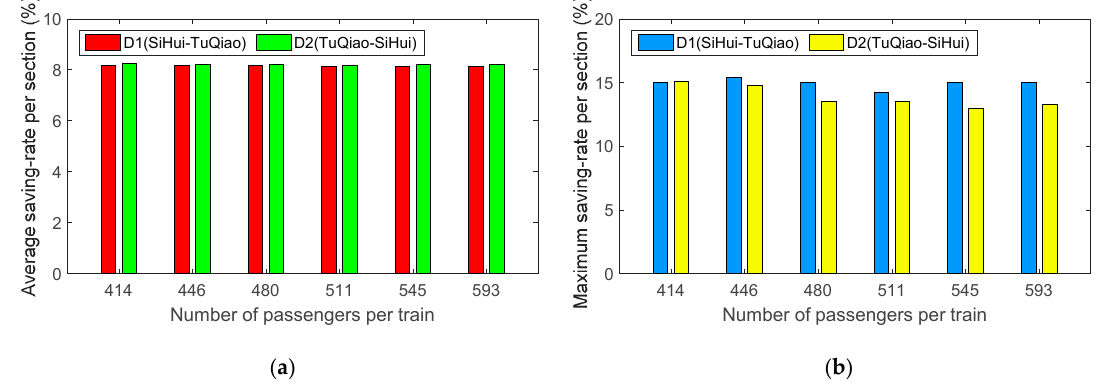
Figure 16. Statistical results of average energy reduction per section from the weekend timetable. ( a ) Comparison of average results; ( b ) Comparison of maximum results.